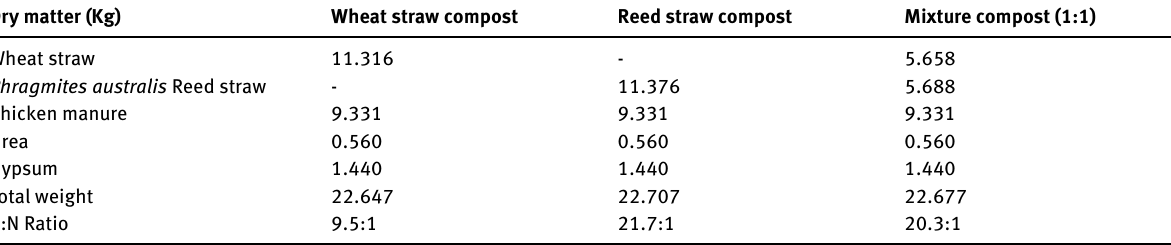
Table 5: Reed straw composts in Iraq (Owaid 2009; Muslat et al. 2014; Owaid et al. 2017) Dry matter (Kg)